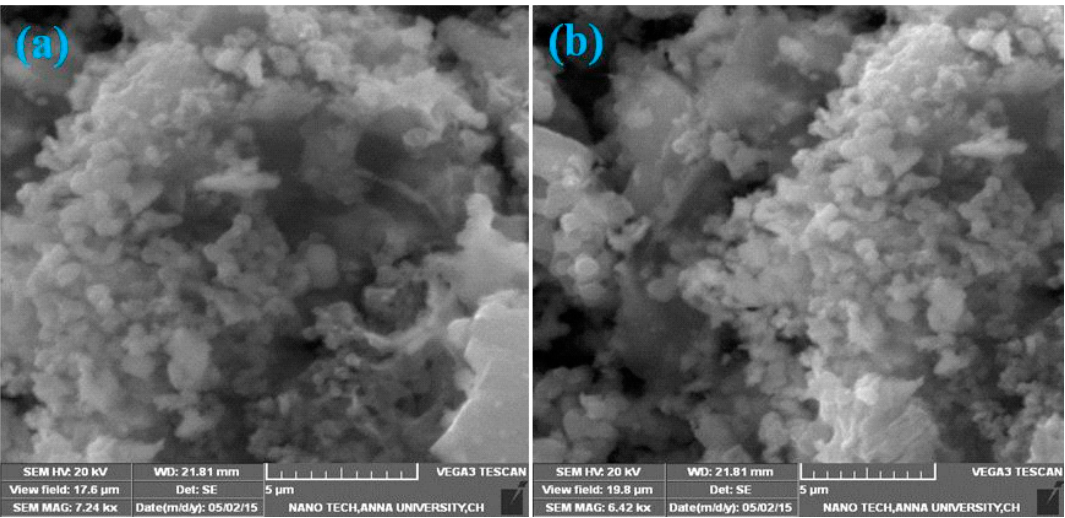
/ G nanocomposite annealed at 600 ◦ C. Nanomaterials 2020 , 10 , x FOR PEER REVIEW